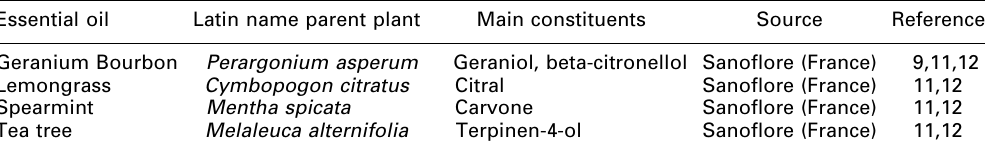
Table 1. Essential oils, their main constituents, their sources and manufacturers